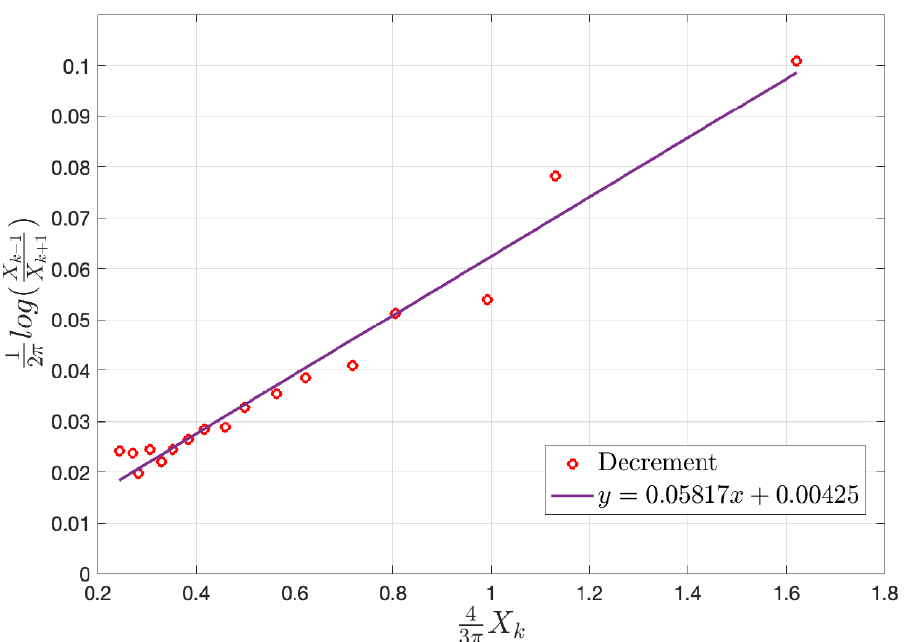
Figure 14. Extinction curve for the free decay test of pitch obtained from CFD simulation with Comb.1.